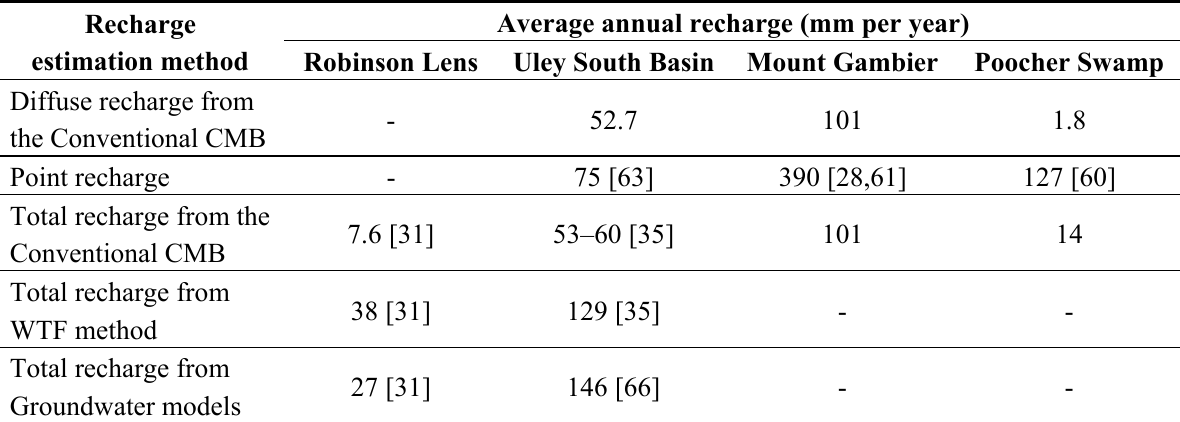
Table 2. Comparison of recharge estimates with point